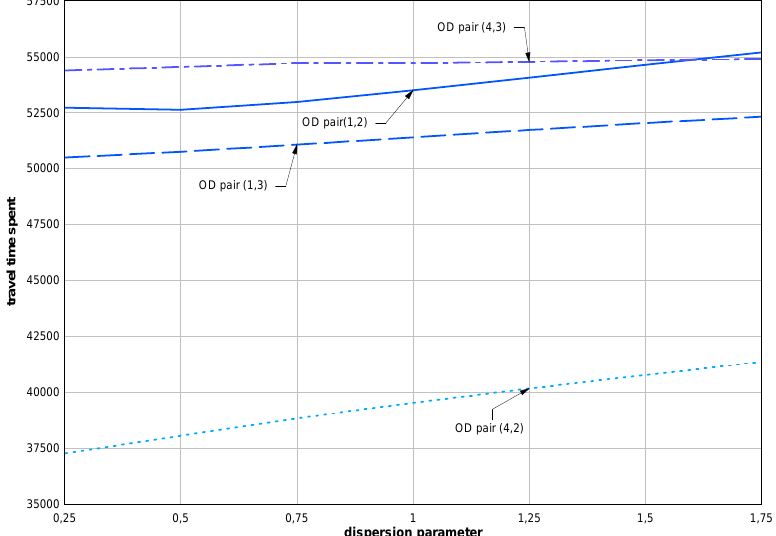
Figure 8. Variation of total travel time spent on the network with dispersion